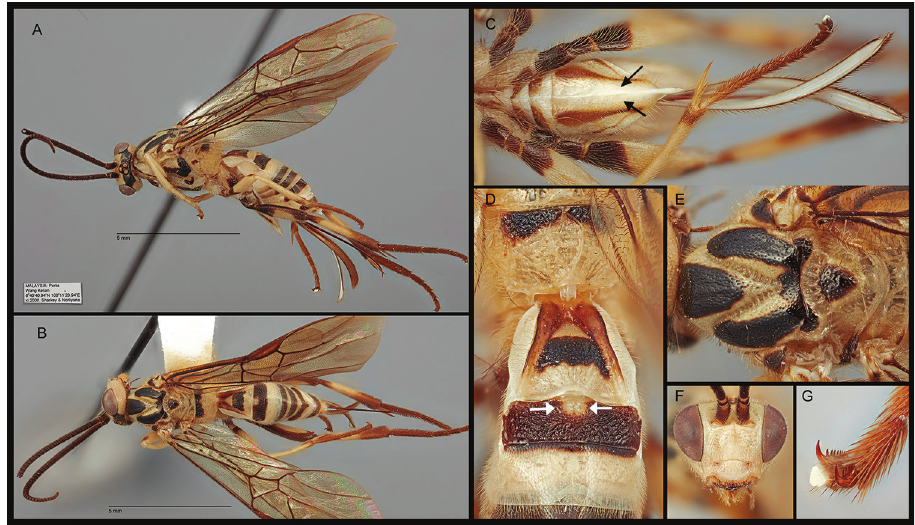
Figure 2. Orientocardiochiles joeburrowi sp. nov., holotype. A Lateral habitus B dorsal habitus C ventral metasoma; arrow: hypopygium D dorsal propodeum and metasomal terga 1–3; arrow: plateau-like pro- jection E dorsal mesonotum F anterior head G